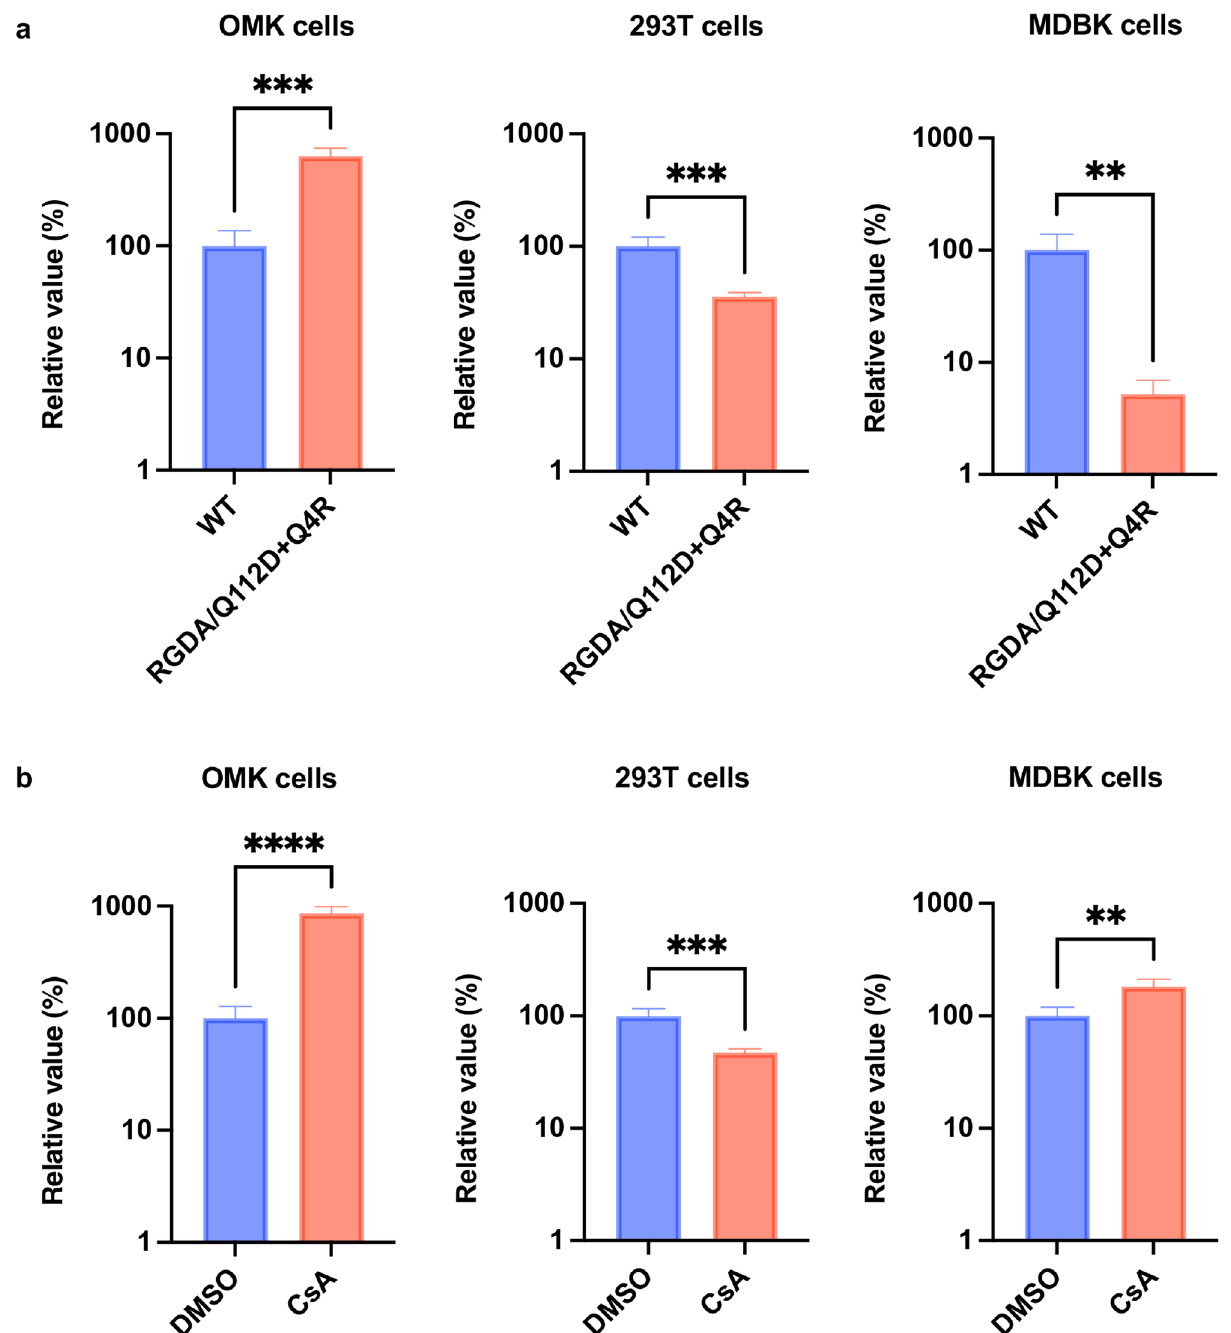
Figure 5. CsA treatment significantly enhanced HIV-1 infectivity in MDBK cells. ( a ) OMK (left), Lenti-X 293T (center), and MDBK cells (right) were infected with the WT virus or RGDA/Q112D + Q4R CA mutant encoding luciferase reporter protein. The infectivity was determined as relative light units (RLU) 2 days after infection. Relative infectivity was calculated using the values of the WT virus. ( b ) OMK (left), Lenti-X 293T (center), and MDBK cells (right) were infected with HIV-1 vectors encoding luciferase reporter protein in the presence of DMSO or 2 µM Cyclosporin A (CsA). The infectivity was determined as RLU 2 days after infection. The relative infectivity was calculated according to the control values. The results are presented as the mean and standard deviation of triplicate measurements from one assay, and they are representative of at least three independent experiments. Differences were examined by a two-tailed, unpaired Student’s t -test. **** p < 0.0001, *** p < 0.001, ** p <